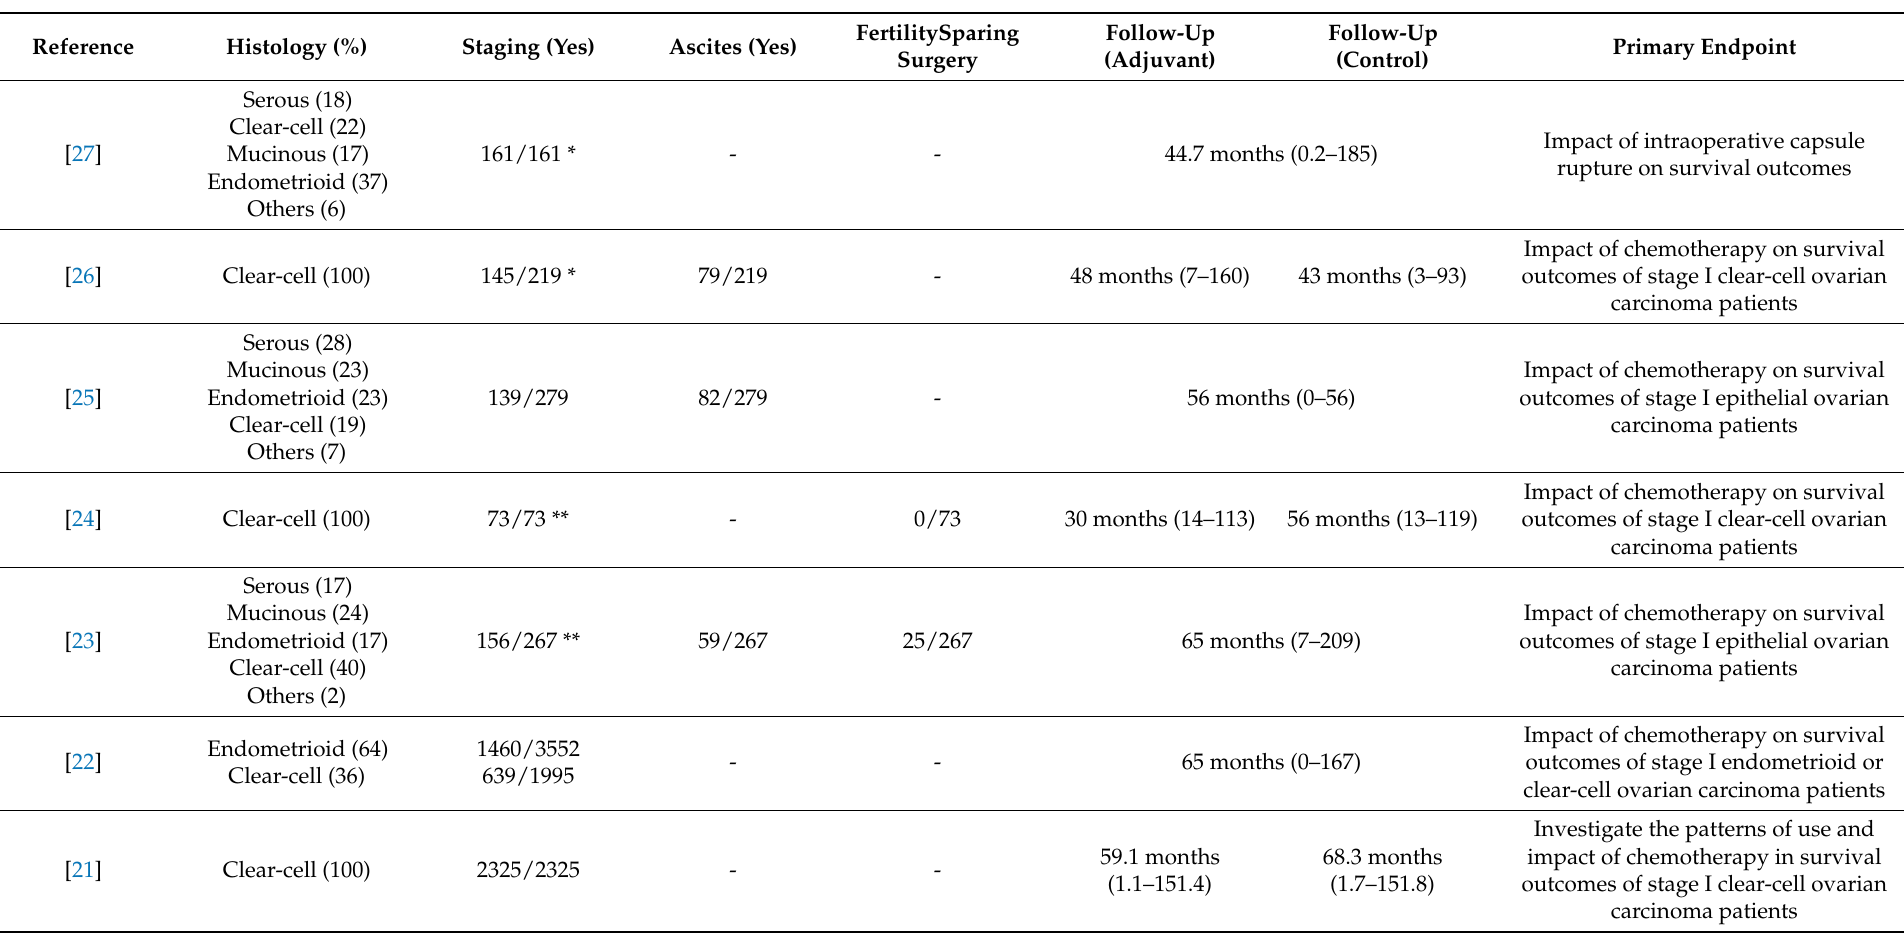
Table 1. Study, tumor and treatment